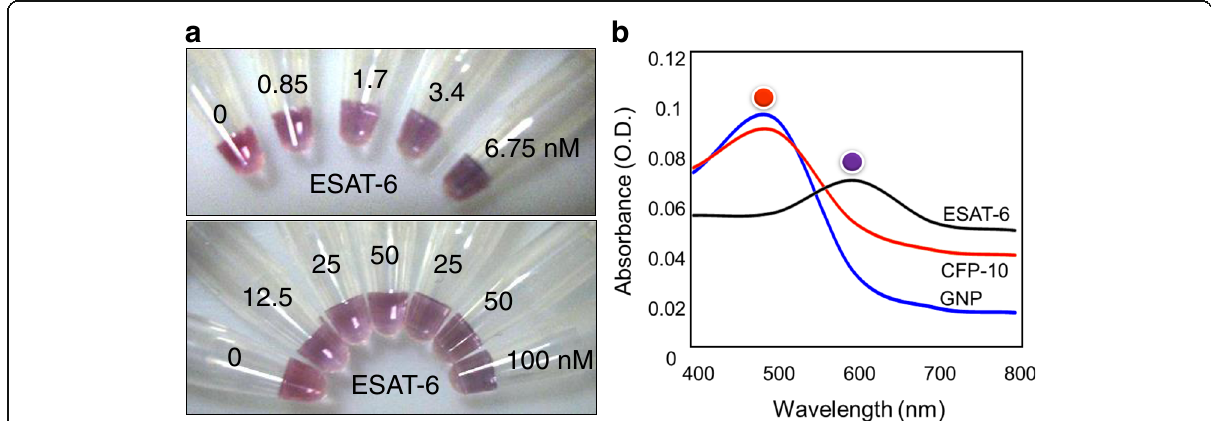
Fig. 7 ESAT-6 detection with 75 nM anti-ESAT-6 antibody. a Representation for color changes. Different concentrations of ESAT-6 was mixed with 75 nM of antibody, and after 30 min of incubation, GNP was added. Then, 800 mM of NaCl was added to induce the color change. ESAT-6 from 0.85 nM was detected with the clear color change (red to blue). Photographs were taken by a digital camera. b Spectral changes at the wavelength from 400 to 800 nm. Peaks were indicated with the respective colored spheres. Specificity assay was carried out using CFP-10 and shown to be a negative